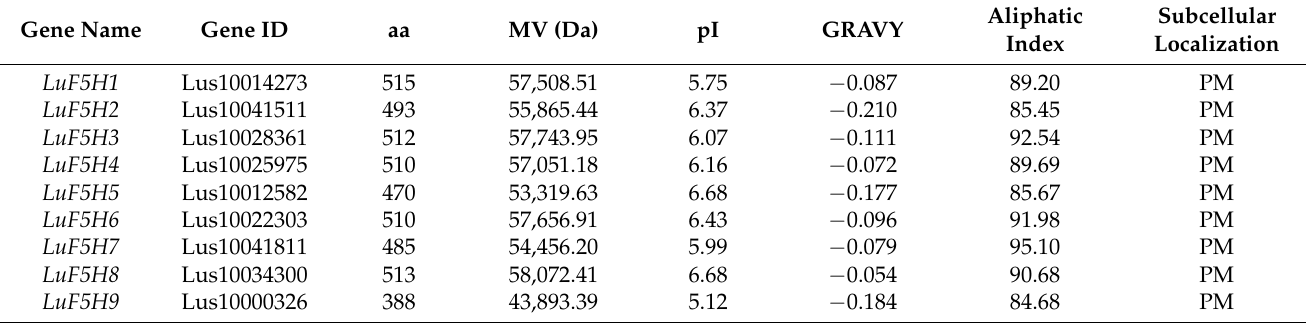
Table 1. Information of LuF5H gene family